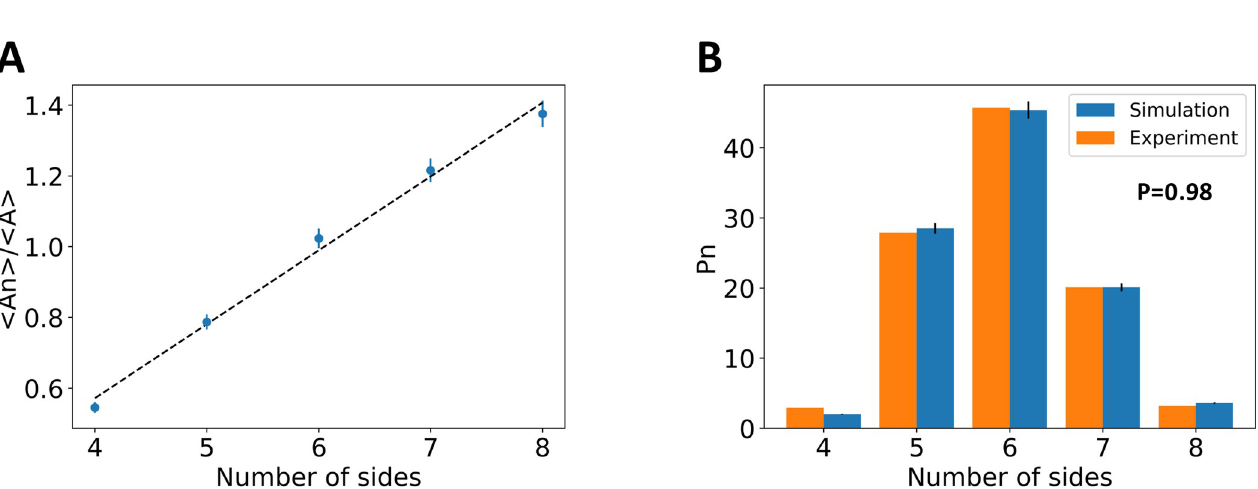
Fig 7. Quantifying epithelial packing during the simulated growth process. A: Average cell area per number of cell sides, divided by the mean area, is plotted versus cell number of sides. The values are obtained by combining data from all frames in the simulation. A linear relationship is observed, in accordance with Lewis’ law. B: Distribution of number of cell sides. The simulation values are obtained by combining data from all frames in the eye disc simulation. The experimental values were obtained from [41] and correspond to Drosophila melanogaster third instar larval wing disc.